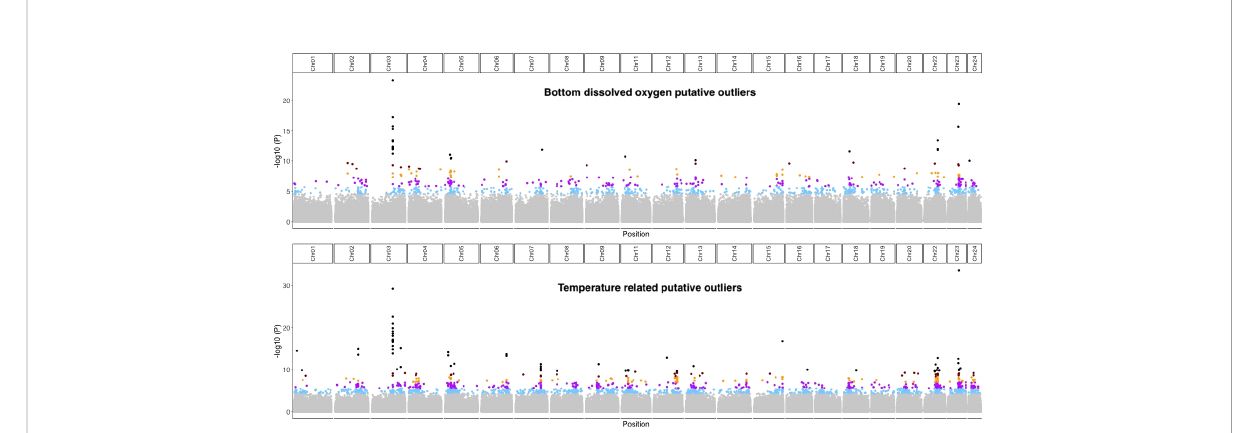
FIGURE 3 Genome-wide Environmental Association detected by LFMM 2 with bottom dissolved oxygen (upper panel) and temperatures related variables (lower panel). The Manhattan plot show the -log10 of the p-value provided by LFMM2 for each SNP. Dots are colored according to False Discovery Rate (black:< 0.00001, brown:<0.0001, orange:< 0.001, purple:< 0.01, light blue:< 0.05 and grey: no